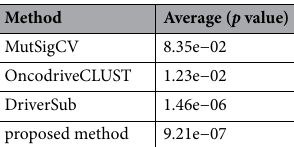
Table 1. Comparing p -values between the previous and the proposed methods for an average of a subset of 200 driver genes the results of comparison between different methods in the method proposed in this paper have an average of p value less for 200 driver